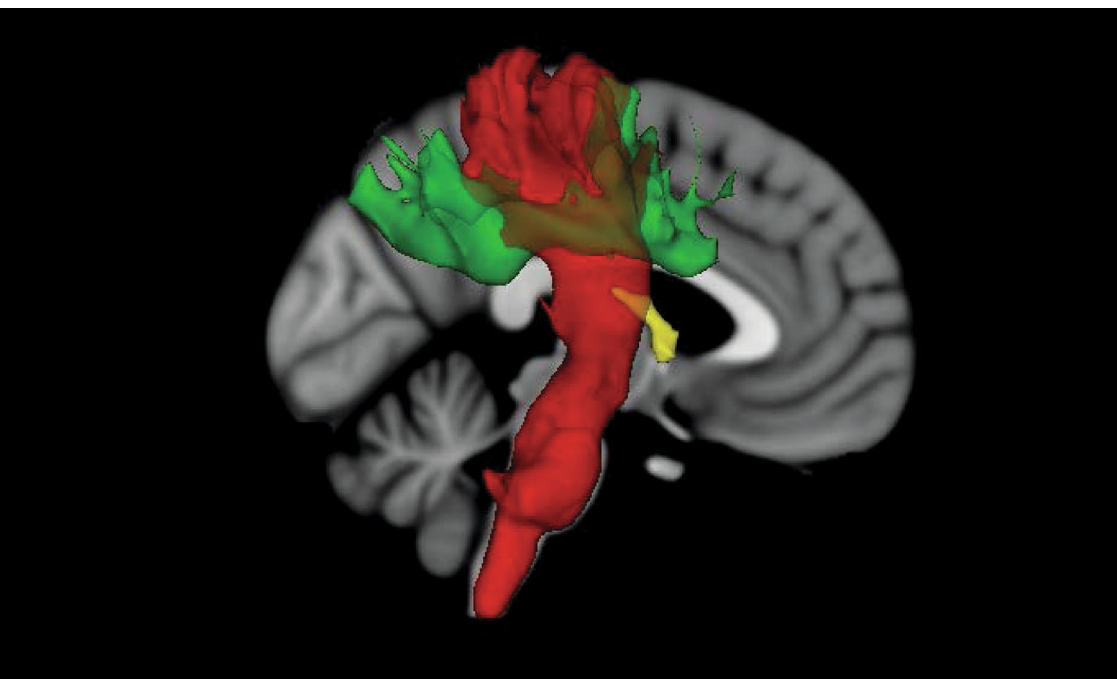
Figure 1: Visualisation of tracts of interest: red — corticospinal tract, green — superior longitudinal fasciculus, and yellow —